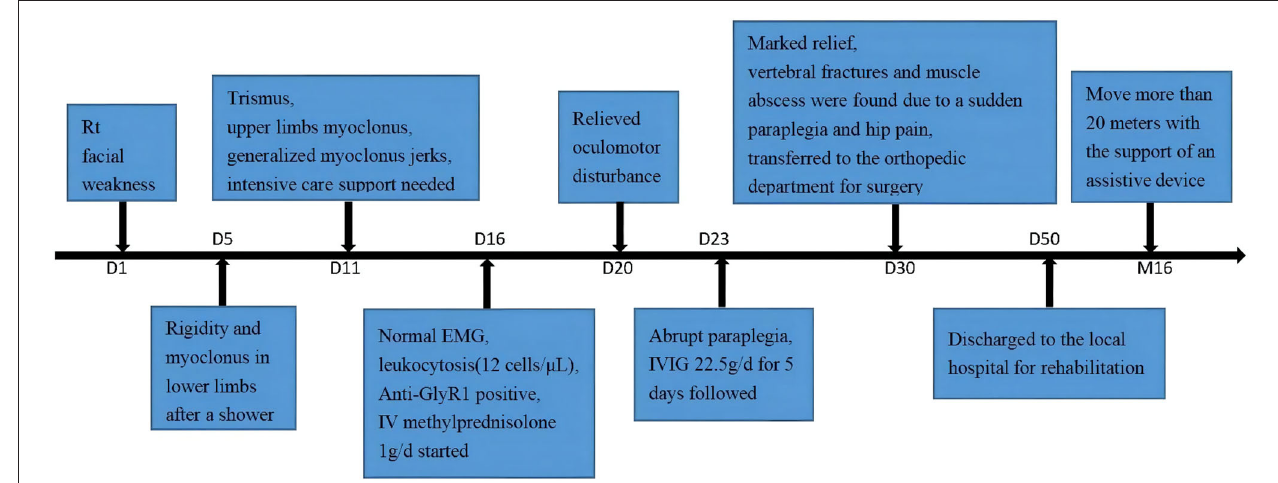
FIGURE 1 | Timeline with diseases’ onset and